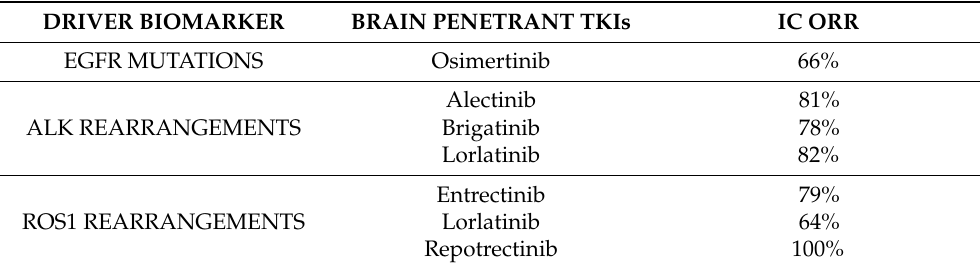
Table 1. The intracranial activity of targeted agents in TKIs-naïve